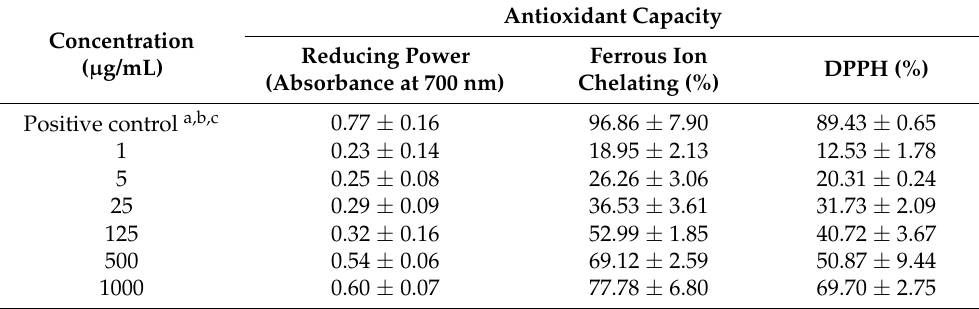
Table 1. Reducing power, ferrous ion chelating, and DPPH were used to test the ROS removing ability in